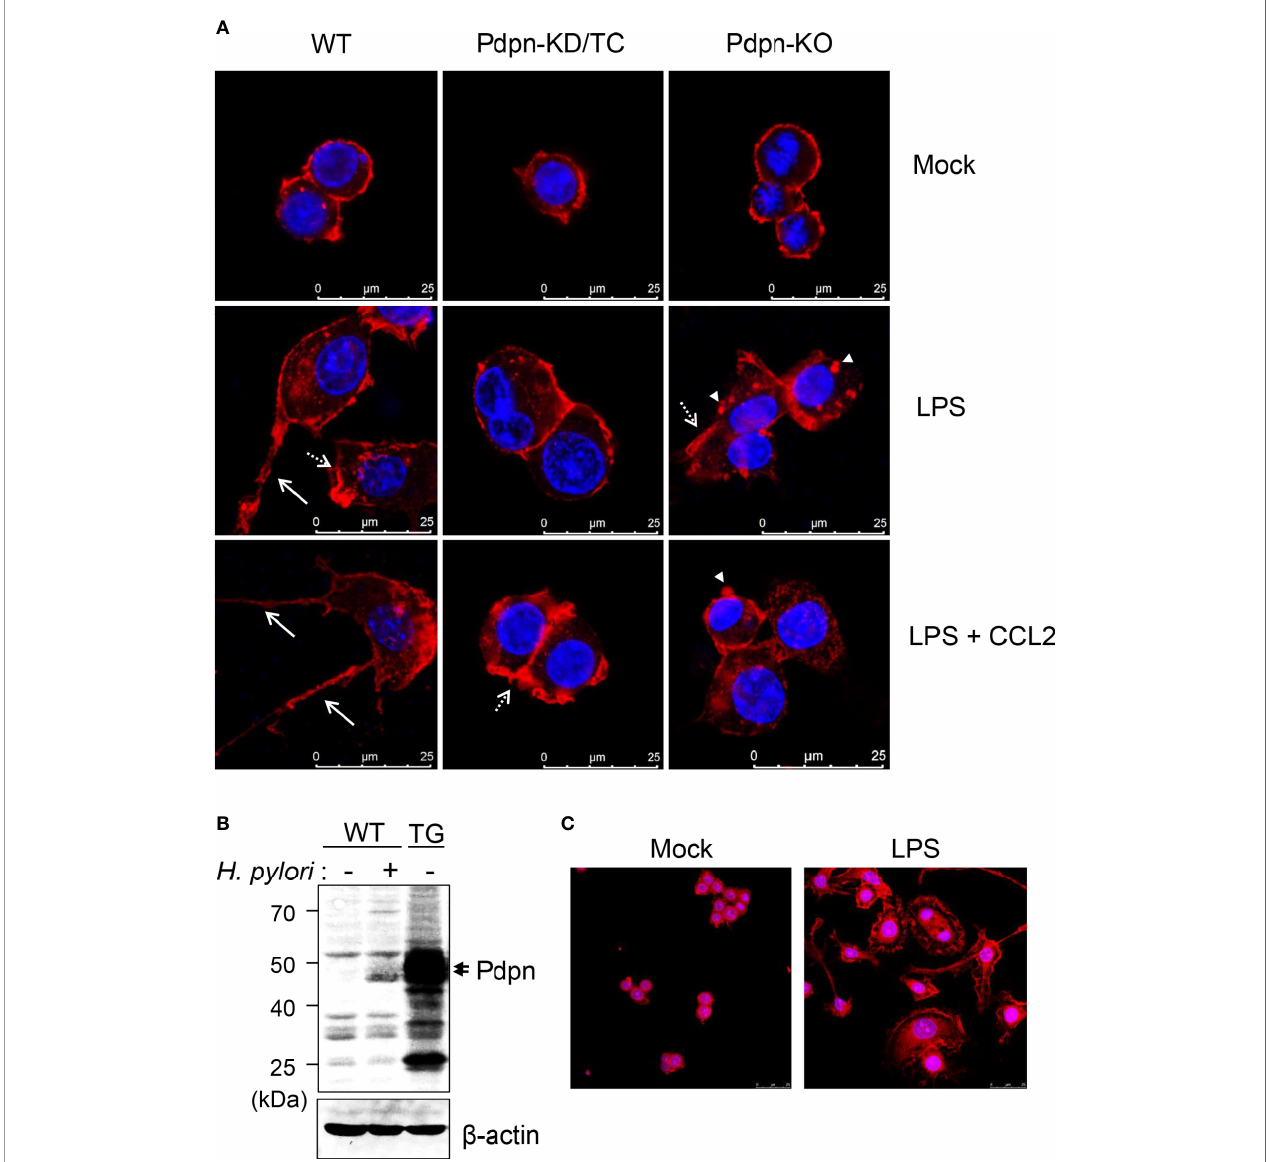
FIGURE 3 | Altered fi lopodia formation in the Pdpn -knockout and overexpressed cells. (A) Representative immuno fl uorescence images of wild-type, Pdpn -KD/TC, and Pdpn -KO cells with or without treatment with 10 µg/ml LPS (and 100 ng/ml CCL2). Note that actin cytoplasmic tails or fi lopodia protrusions (arrow) were only detected in the wild type, while membrane ruf fl es or lamellipodia (broken arrow) and podosomes (arrowhead) can be observed in the mutant clones. Cells were stained with anti- b -actin antibody followed by Alexa Fluor 555-conjugated rabbit anti-rabbit IgG (H+L) F(ab ’ ) 2 to view actin cytoskeleton (red) and nucleus were counterstained with DAPI (blue). Scale bars represent 25 m m. (B) Generation of Pdpn -overexpression clone. Immunoblot analysis of Pdpn in uninfected or H. pylori (MOI 10, 24 h)-infected wild-type cells, and unstimulated Pdpn -TG stable clone. Membranes were probed using anti-Pdpn or anti- b -actin antibodies. Ladder indicates molecular weight, kDa: kiloDalton. (C) Representative immuno fl uorescence images of Pdpn -TG cells with or without treatment with 1 µg/ml LPS. Note the extensive fi lopodia protrusions around the activated cells. Cells were stained as described in (A) . Scale bars represent 25 m